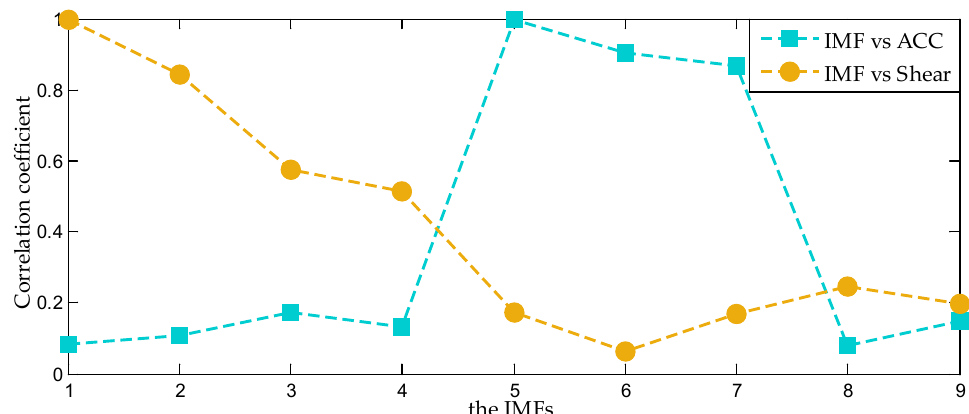
Figure 8. The correlation coefficients for each IMF and the three-axis acceleration as well as the raw shear.